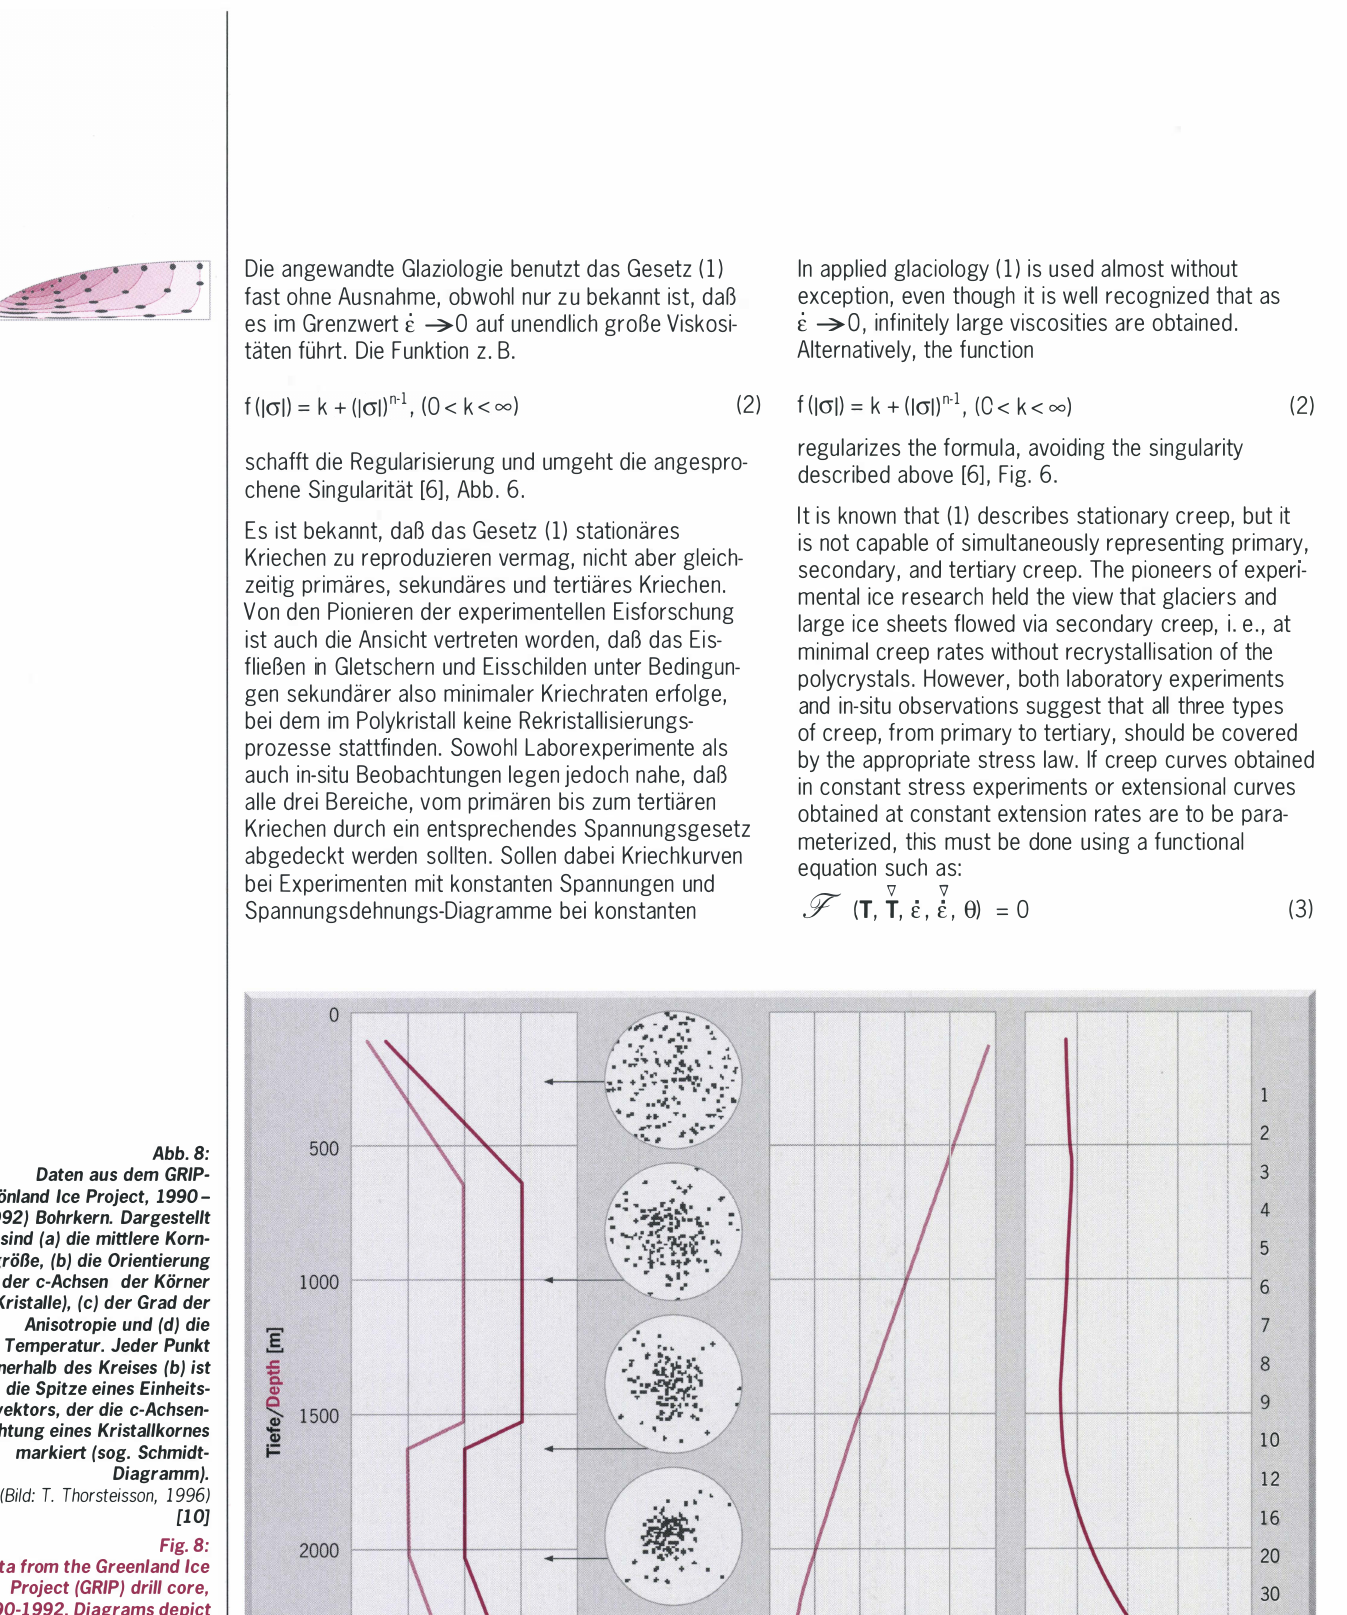
markiert (sog. Schmidt­ Diagramm}.